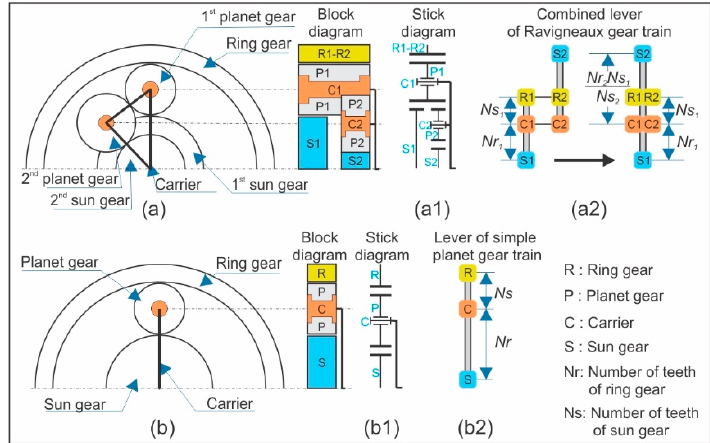
Figure 1. Main components of considered HT system: ( a ) Ravigneaux gear train; ( b ) simple planetary gear train.